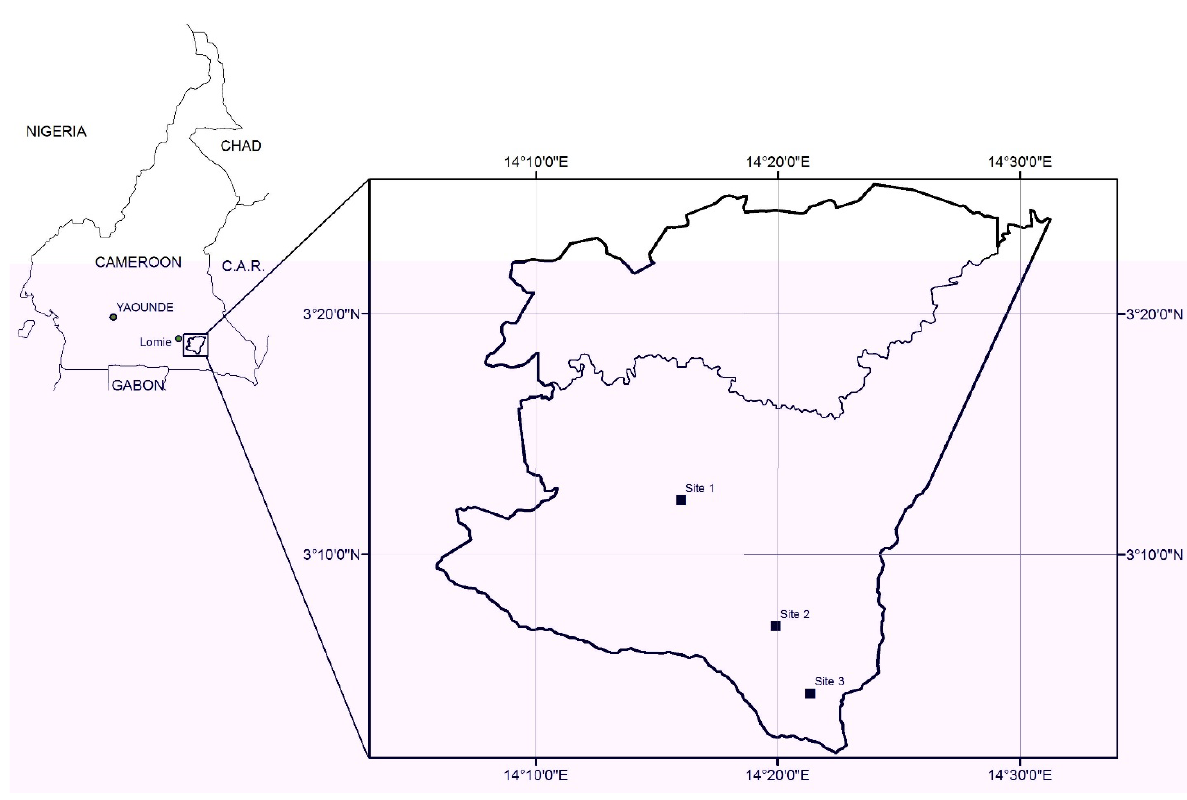
Figure 1. Location of the study area, a forest concession in Cameroon of 118,052 ha. The geographical positions of the study sites are represented by black squares. The Boumba River flows westbound across the study area (shown on the